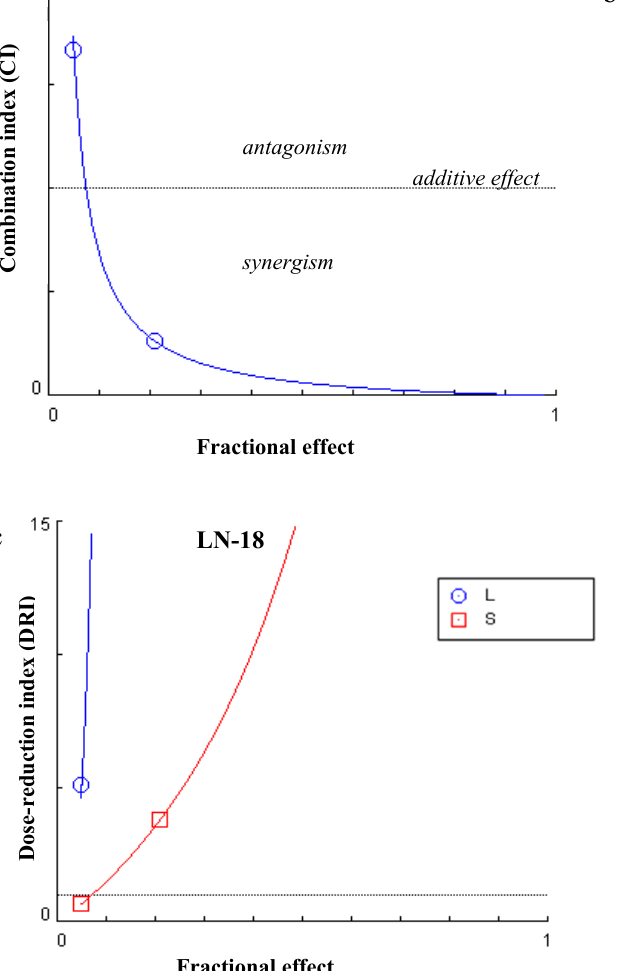
Figure A4. Lensoside A β (L) and sorafenib (S) combination treatment. ( a ) Combination index (CI) plot: The combination index is plotted as a function of Fa (fractional effect). ( b ) Isobologram for combination: isobologram at IC50, IC75, and IC90. ( c ) the F a -DRI (dose reduction index) plot (Chou-Martin plot). Combination index (CI) and dose reduction index (DRI) were calculated according to the method of Chou and Talalay using the Compusyn software. CI < 1, CI = 1 and CI > 1 indicate synergistic effect, additive effect, and antagonistic effect, respectively. Synergy (CI < 1) at high effect levels (at fa > 0.90) is more relevant to anticancer therapeutic effect than the CI at low effect levels (at fa < 0.3). The combination of